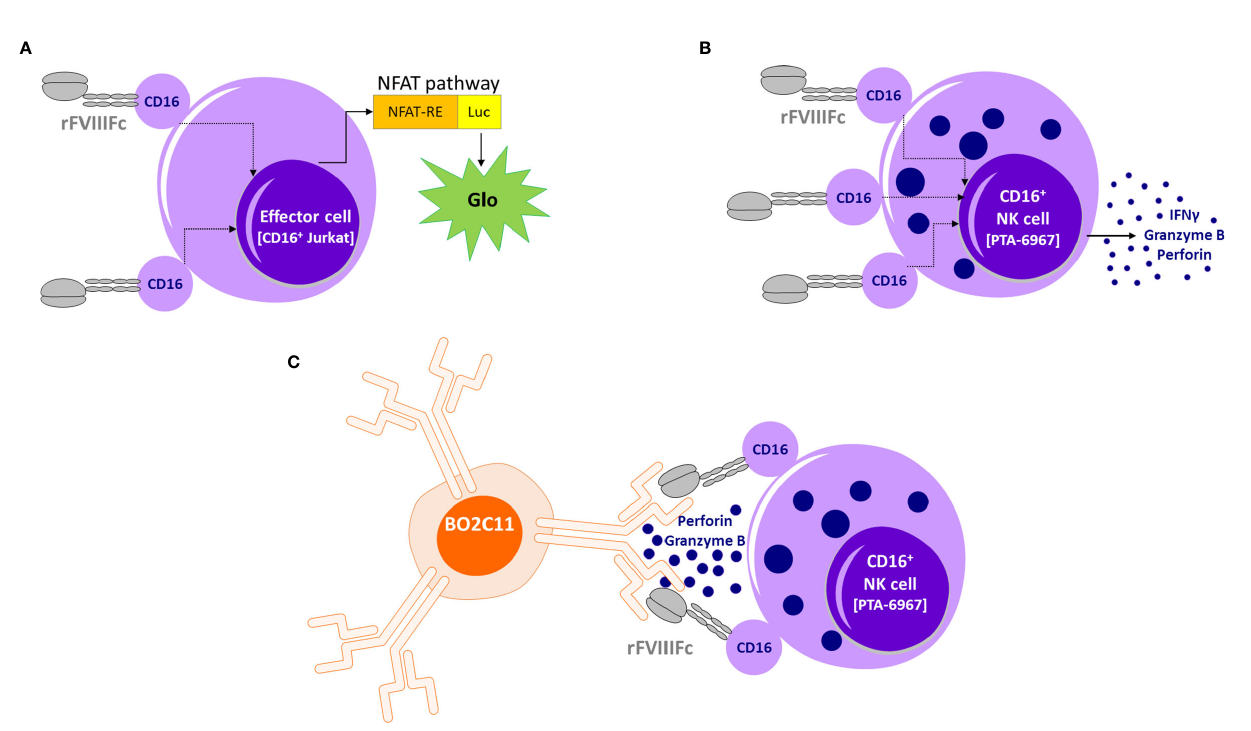
FIGURE 5 | Proposed model of rFVIIIFc : CD16 interactions. (A) An illustration depicting interactions between rFVIIIFc and CD16 + ADCC Reporter Bioassay effector cells resulting in luciferase activity. (B) An illustration depicting interactions between rFVIIIFc and CD16 + NK cells leading to IFN g , granzyme B, and perforin release. (C) An illustration depicting interactions between rFVIIIFc and CD16 and a putative mechanism by which rFVIIIFc can target anti-FVIII memory B-cells